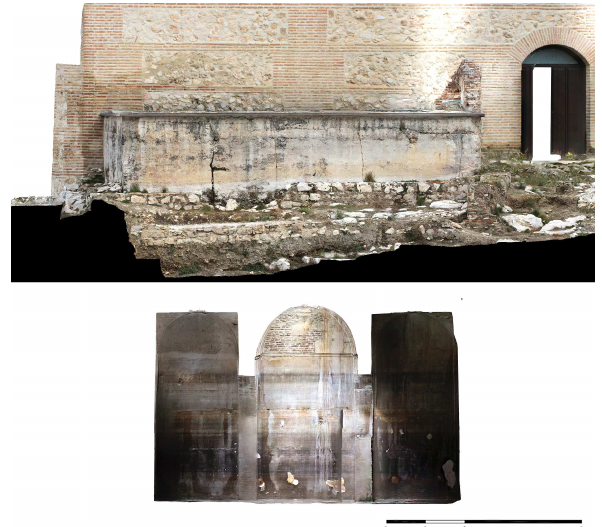
Figure 4. Outside and inside orthophotographs of the cistern of the fortress of Loja.